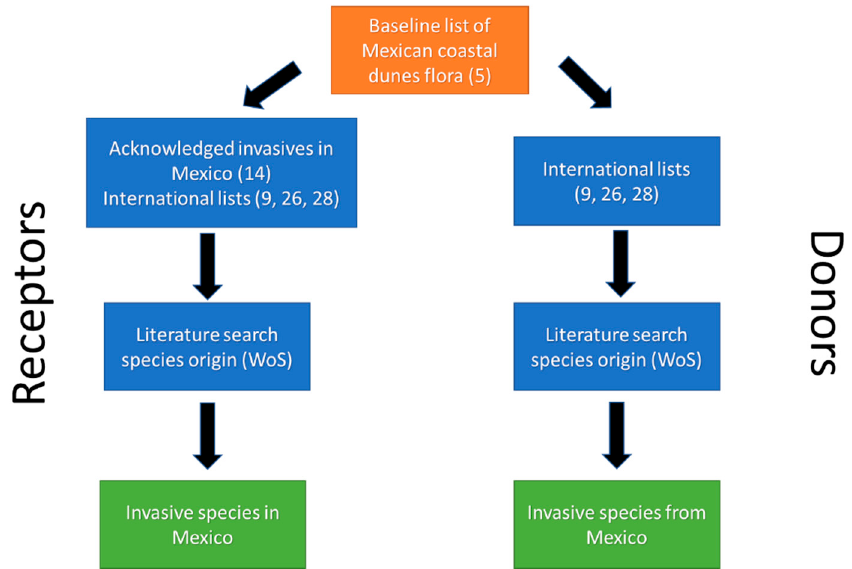
Figure 1. Combination of floristic lists and databases to elaborate a single list of invasive species on Mexican coastal dunes both as recipients (invasive in Mexico) and donors (native Mexican, invasive elsewhere). Numbers in parenthesis indicate the references from where information was gathered to perform the analyses.